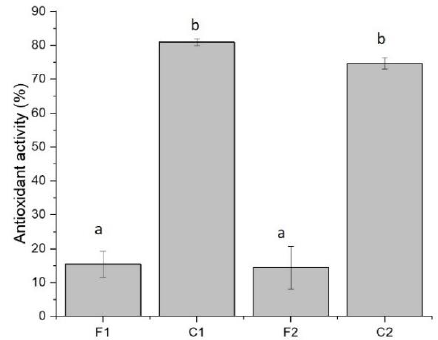
Figure 6. Antioxidant activity of film samples containing curcumin. F1 (1GE: 1SFTG); F2 (2GE: 1SFTG); C1 (1GE: 1 SFTG/curcumin); C2 (2GE: 1SFTG/curcumin). Different letters show significantly different ( p < 0.05)